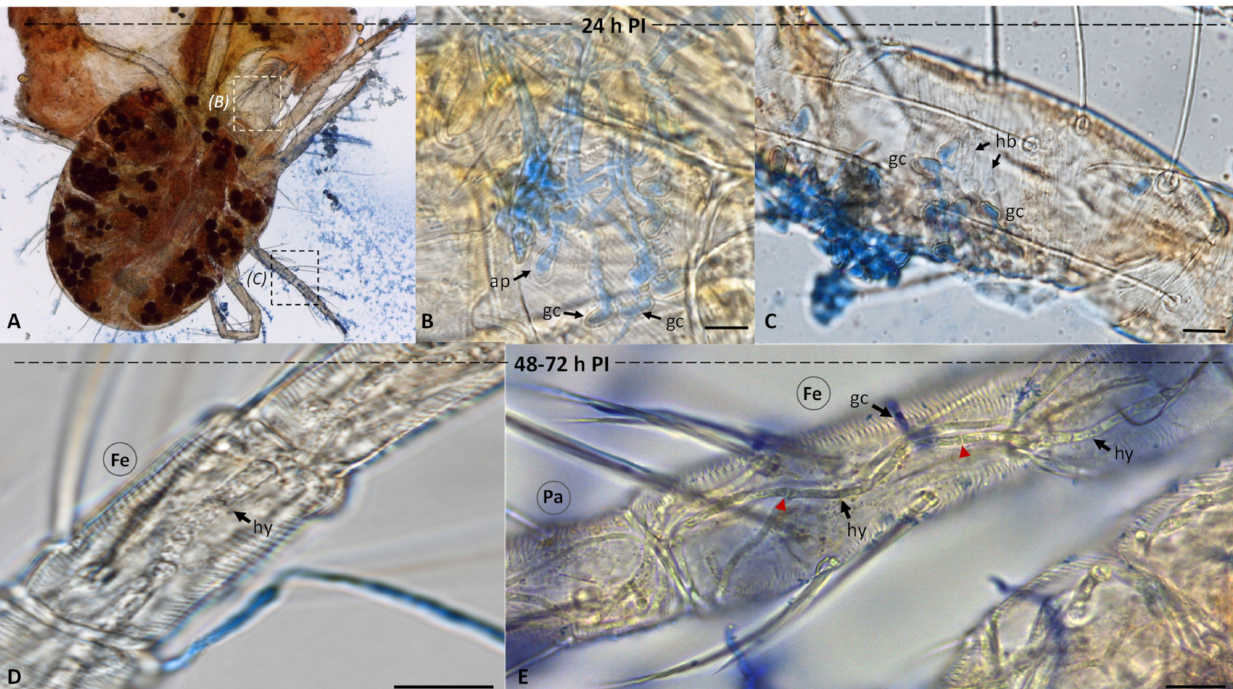
Figure 1. Light micrographs of cassava mites infected with Metarhizium sp. BCC 4849 stained with lactophenol blue 24–72 h post-inoculation (PI). ( A ) At 24 PI, a fungal-colonized mite was observed. ( B , C ) Germinating conidia (gc), appressoria (ap), and hyphal bodies (hb) were found at the side of the insect body and the leg, respectively. The infection sites were close to the bases of seta on a living mite, Bars, 10 µ m. ( D ) At 48–72 h PI, we observed dead cassava mites filled with Metarhizium sp. BCC 4849 cells. The hyphae (hy) were found in the hemocoel at the femur (Fe). Bar, 10 µ m. ( E ) A network of several hyphae colonized the femur and patella (Pa). Bar, 20 µ